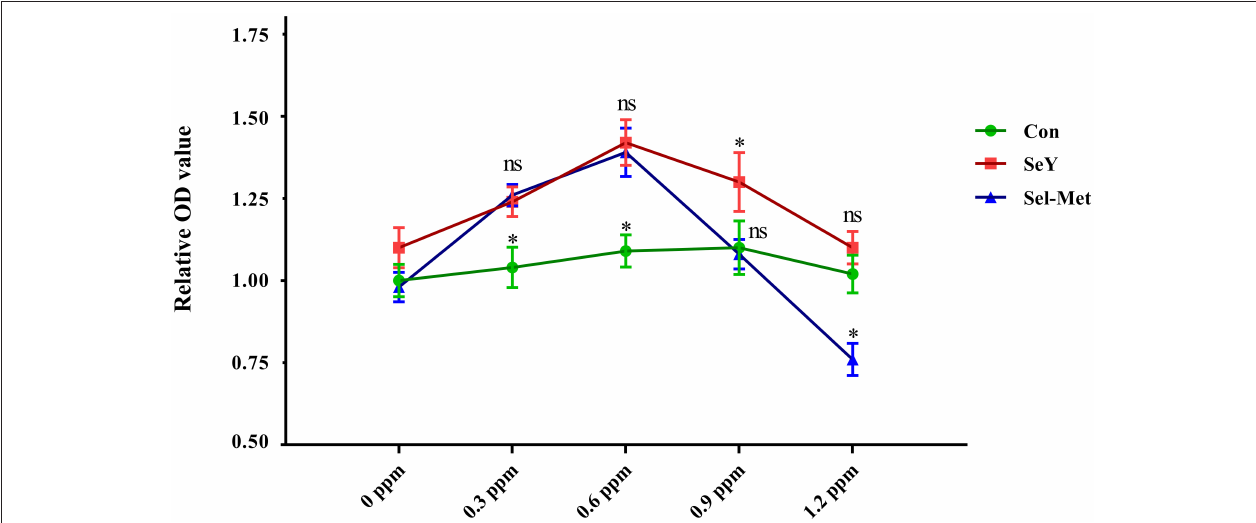
FIGURE 1 | Effects of SeY and Sel-Met supplementation on cell viability in PMECs. Cells were incubated with different concentrations of SeY and Sel-Met (0, 0.3, 0.6, 0.9, and 1.2 ppm) for 24h, respectively. Cell viability was analyzed using the CCK-8 assay. Data are expressed as mean ± SEM ( n = 12). Superscript * indicates significant ( P < 0.05).